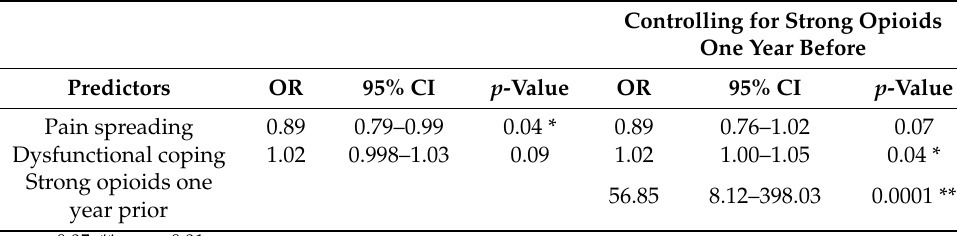
Table 5. Prediction of LTOT in the sample who did not participate in IMMRP ( N = 1013). Predictors OR 95% CI p -Value p -Value Dysfunctional